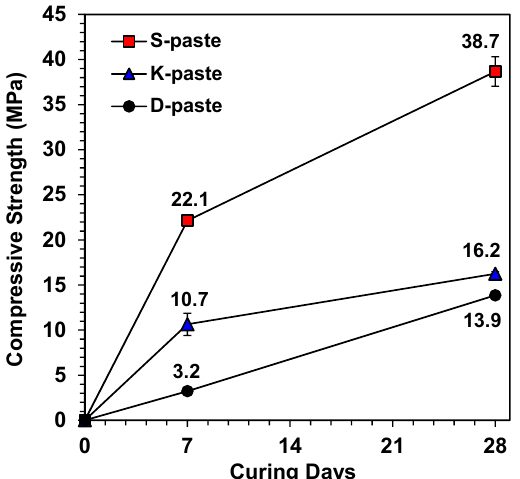
Figure 3. Strength developments of self ‐ activation of GGBFS mixed with purified water.